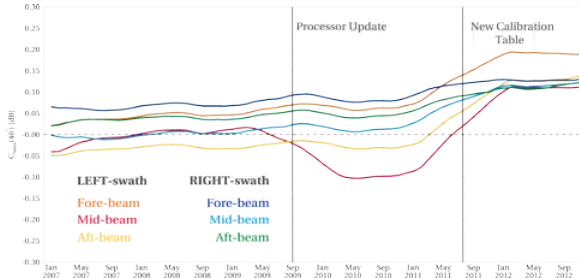
Figure 1: Radiometric stability of ASCAT from 2007 to 2013